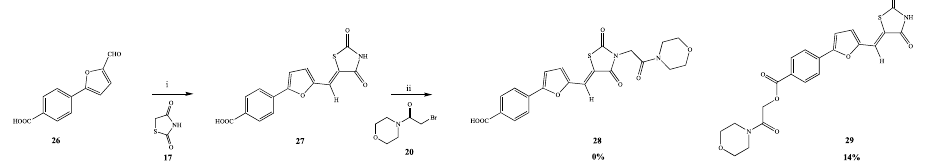
Figure 6. Alternative method for the preparation of the free acid derivative. (i) β -alanine, AcOH, 100 °C 1 h; (ii)